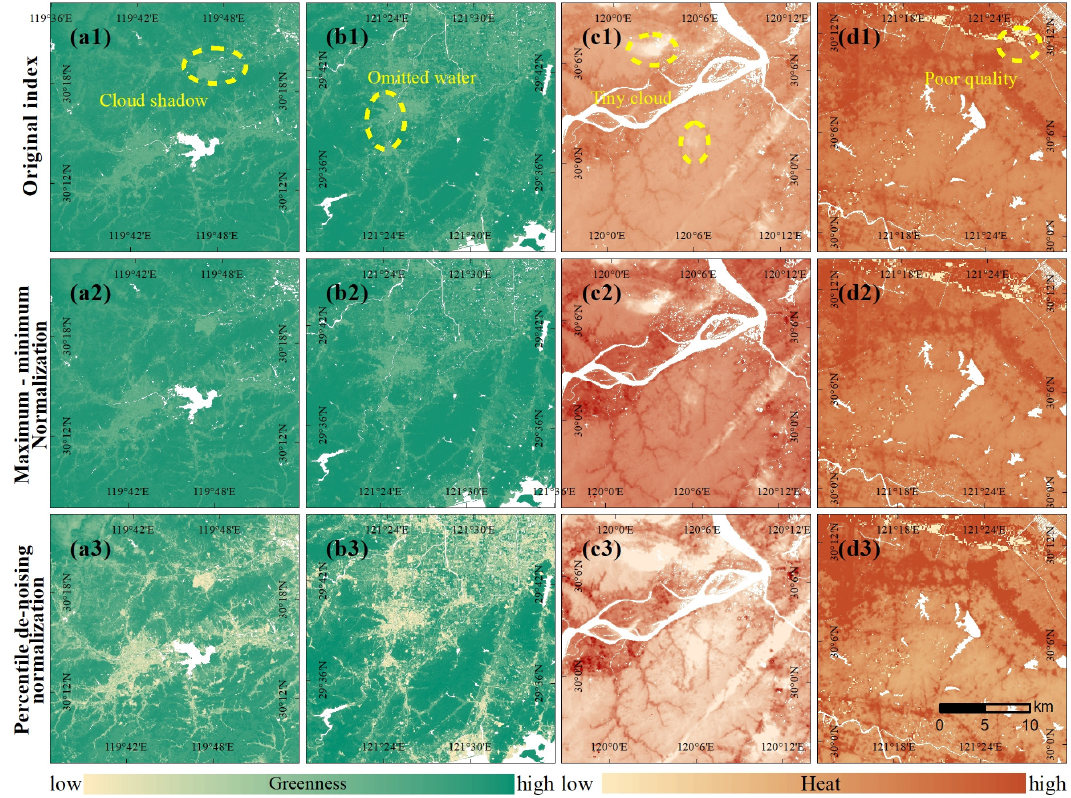
Figure 2. Performance comparison between the maximum–minimum normalization and percentile de-noising normalization: ( a1 , b1 ) original NDVI from two typical regions; ( a2 , b2 ) normalized NDVI using the maximum and minimum values; ( a3 , b3 ) normalized NDVI after percentile (0.5) de-noising; ( c1 , d1 ) original LST from two typical regions; ( c2 , d2 ) normalized LST using the maximum and minimum values; ( c3 , d3 ) normalized LST after percentile (1.5) de-noising.